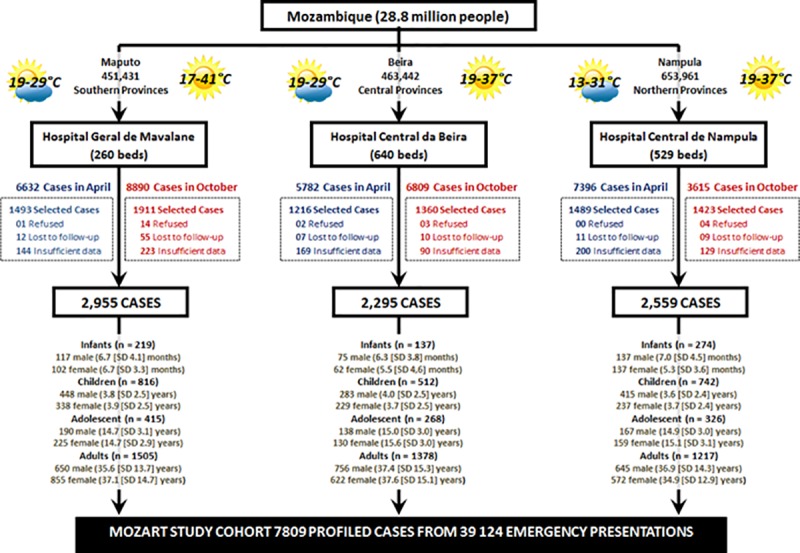
Overview of the MOZART Study cohort.Randomly selected cases without data comprised 10.5%/15.3% of cases in Maputo, 14.6%/7.8% of cases in Beira & 14.2%/10.0% in Nampula for the April/October survey periods. Historical weather data from: https://www.timeanddate.com/weather/mozambique (accessed May 2018).